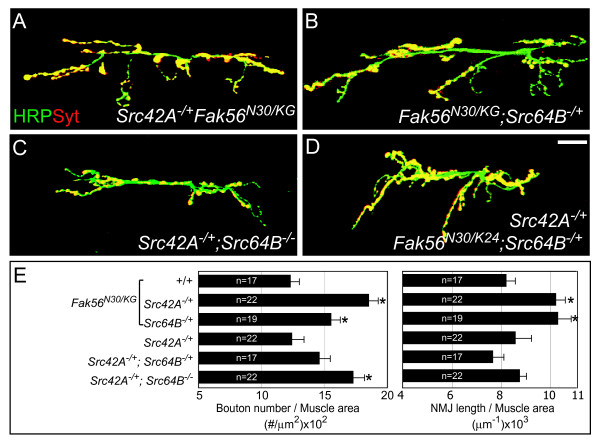
Role of Src and its genetic interaction with Fak56 during neuromuscular junction (NMJ) growth. (A-D) Images of NMJ 6/7 are shown as in Figure 1. Fak56N30/KG mutants carrying one allele of Src42AE1 (A) or Src64BPI (B) displayed NMJ overgrowth phenotype. (C) NMJ phenotype in the severe Src mutant Src42AE1/+;Src64BPI/PI. (D) NMJ phenotype of the Fak56N30/K24 null mutant was enhanced by removing both one Src42AE1 and one Src64BPI allele. (E) Quantification of NMJ 6/7 phenotypes for Fak56N30/KG (the same set of data as in Figure 2G), Src42AE1/+ Fak56N30/KG, Fak56N30/KG;Src64BPI/+, Src42AE1/+, Src42AE1/+;Src64BPI/+ and Src42AE1/+;Src64BPI/PI. Note that Src42AE1/+ and Src42AE1/+;Src64BPI/+show no significant alteration in NMJ phenotypes when compared to wild-type. Asterisks indicate significant difference by Student's t test (p < 0.05) and error bars represent the standard error of the mean (SEM).